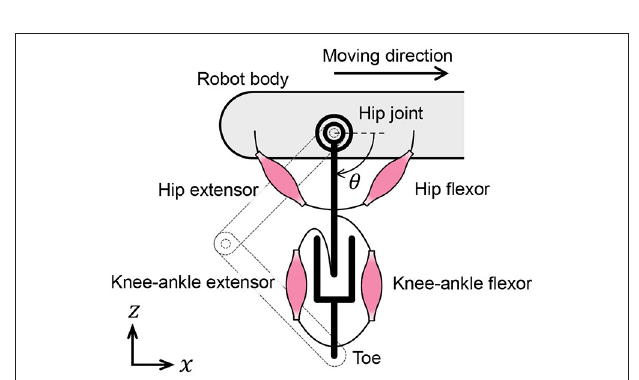
FIGURE 4 | Placement of muscle models on the quadruped